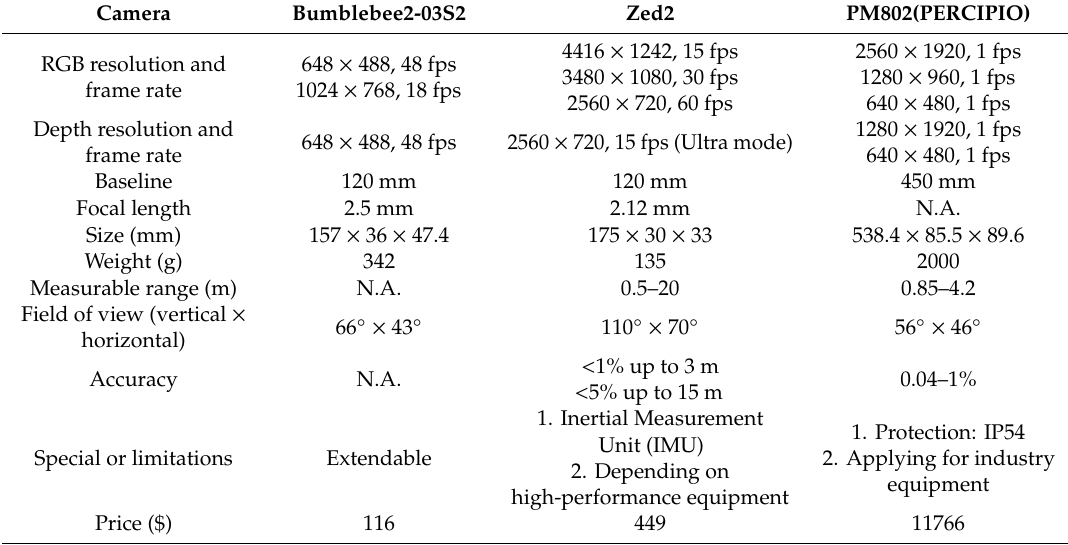
Table 1. Typical binocular stereo